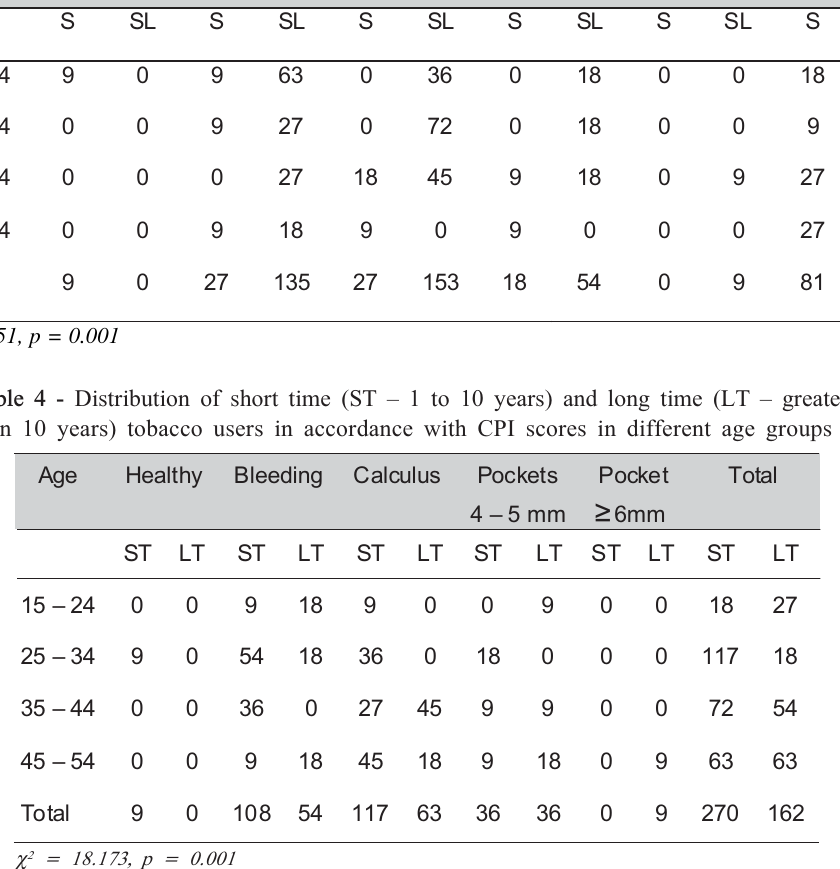
years old age group (53%), followed by the oldest age group (40%). Thirty-three percent of heavy users presented periodontal pockets where as only 4% among the moderate users had pockets ( p =